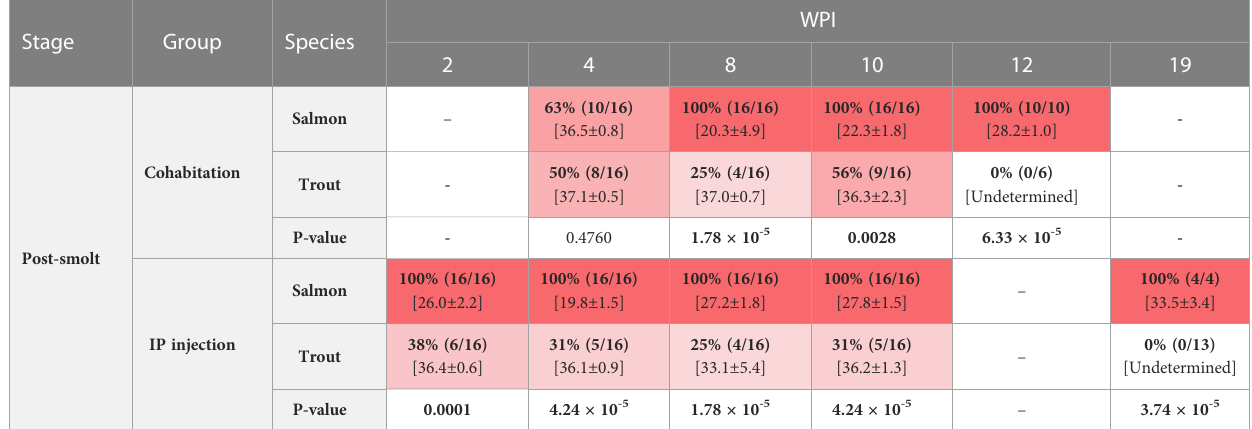
TABLE 4 The prevalence of PRV -1 positive salmon and trout post-smolt at 2, 4, 8, 10, and 12 or 19 WPI.